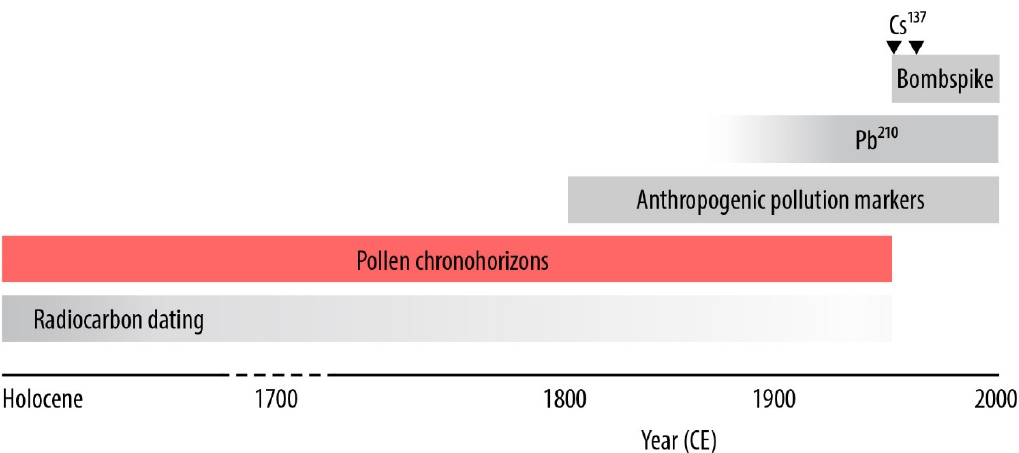
Figure 1. Conceptual diagram of dating techniques and their age ranges highlighting the potential chronological gap between radiocarbon dating and pollution markers that pollen chronohorizons may circumvent.